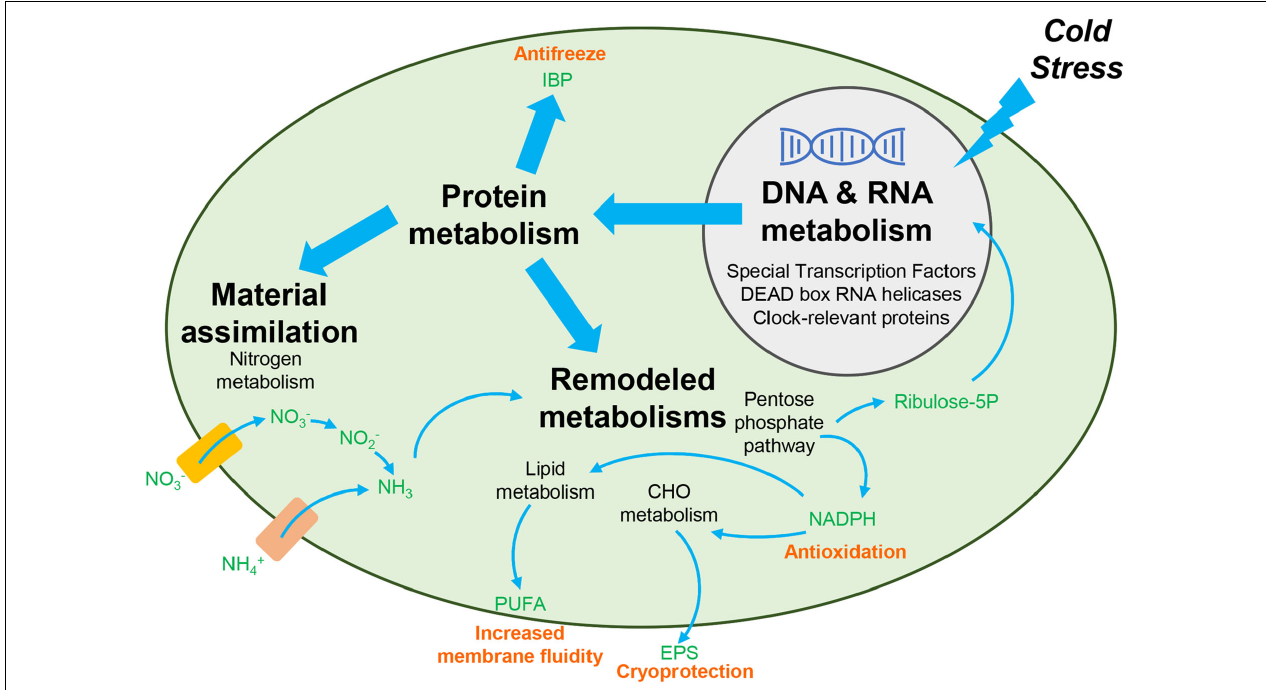
FIGURE 9 | Overview of cold adaptation mechanisms in C. nivalis. Black bold text indicates the main processes in the cold adaptation mechanism, and black non-bolded text indicates the detailed pathways and genes related to the process identified in this study. Green text indicates the chemicals in the pathways. Pink text indicates the function of the compounds in cold resistance. Rectangles indicate the nitrate and ammonium transporters. Upon cold stress from the extracellular environment, signals upstream are transferred to regulate the processing of RNA and synthesis of functional proteins. The functional proteins then allow for increased material assimilation and remodeling of metabolisms, to produce specific chemicals needed for cold resistance. CHO, carbohydrate. EPS, exopolysaccharides. IBP, ice-binding protein. PUFA, polyunsaturated fatty acid. Ribulose-5P, ribulose